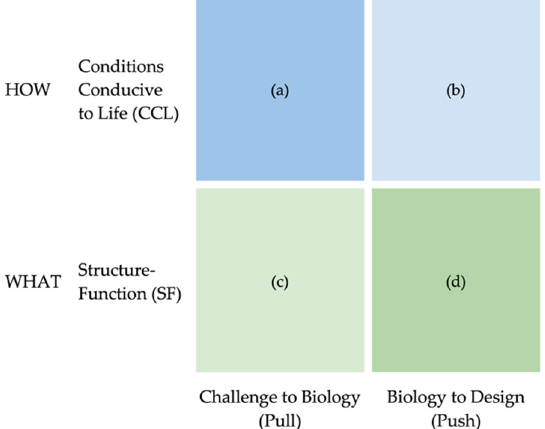
Figure 1. A view of biomimicry practice consisting of processes that span both the Structure-Func- tion ( c , d ) aspects to be learned from nature (What nature does) and the Conditions Conducive to Life ( a , b ) aspects that speak to sustainability (How nature does What it does).